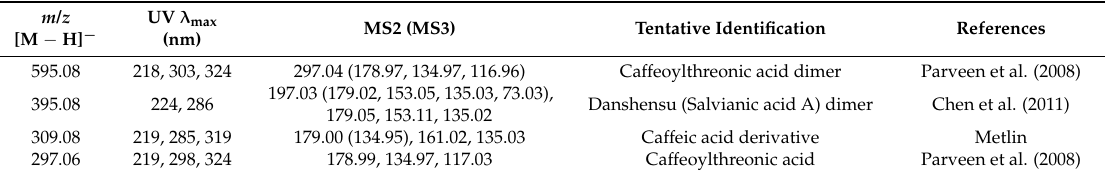
Table 1. Tentative identification of the key anti-inflammatory compounds in sub-fraction 1-3 from the 75% ethanol extract of Actinidia arguta leaves.